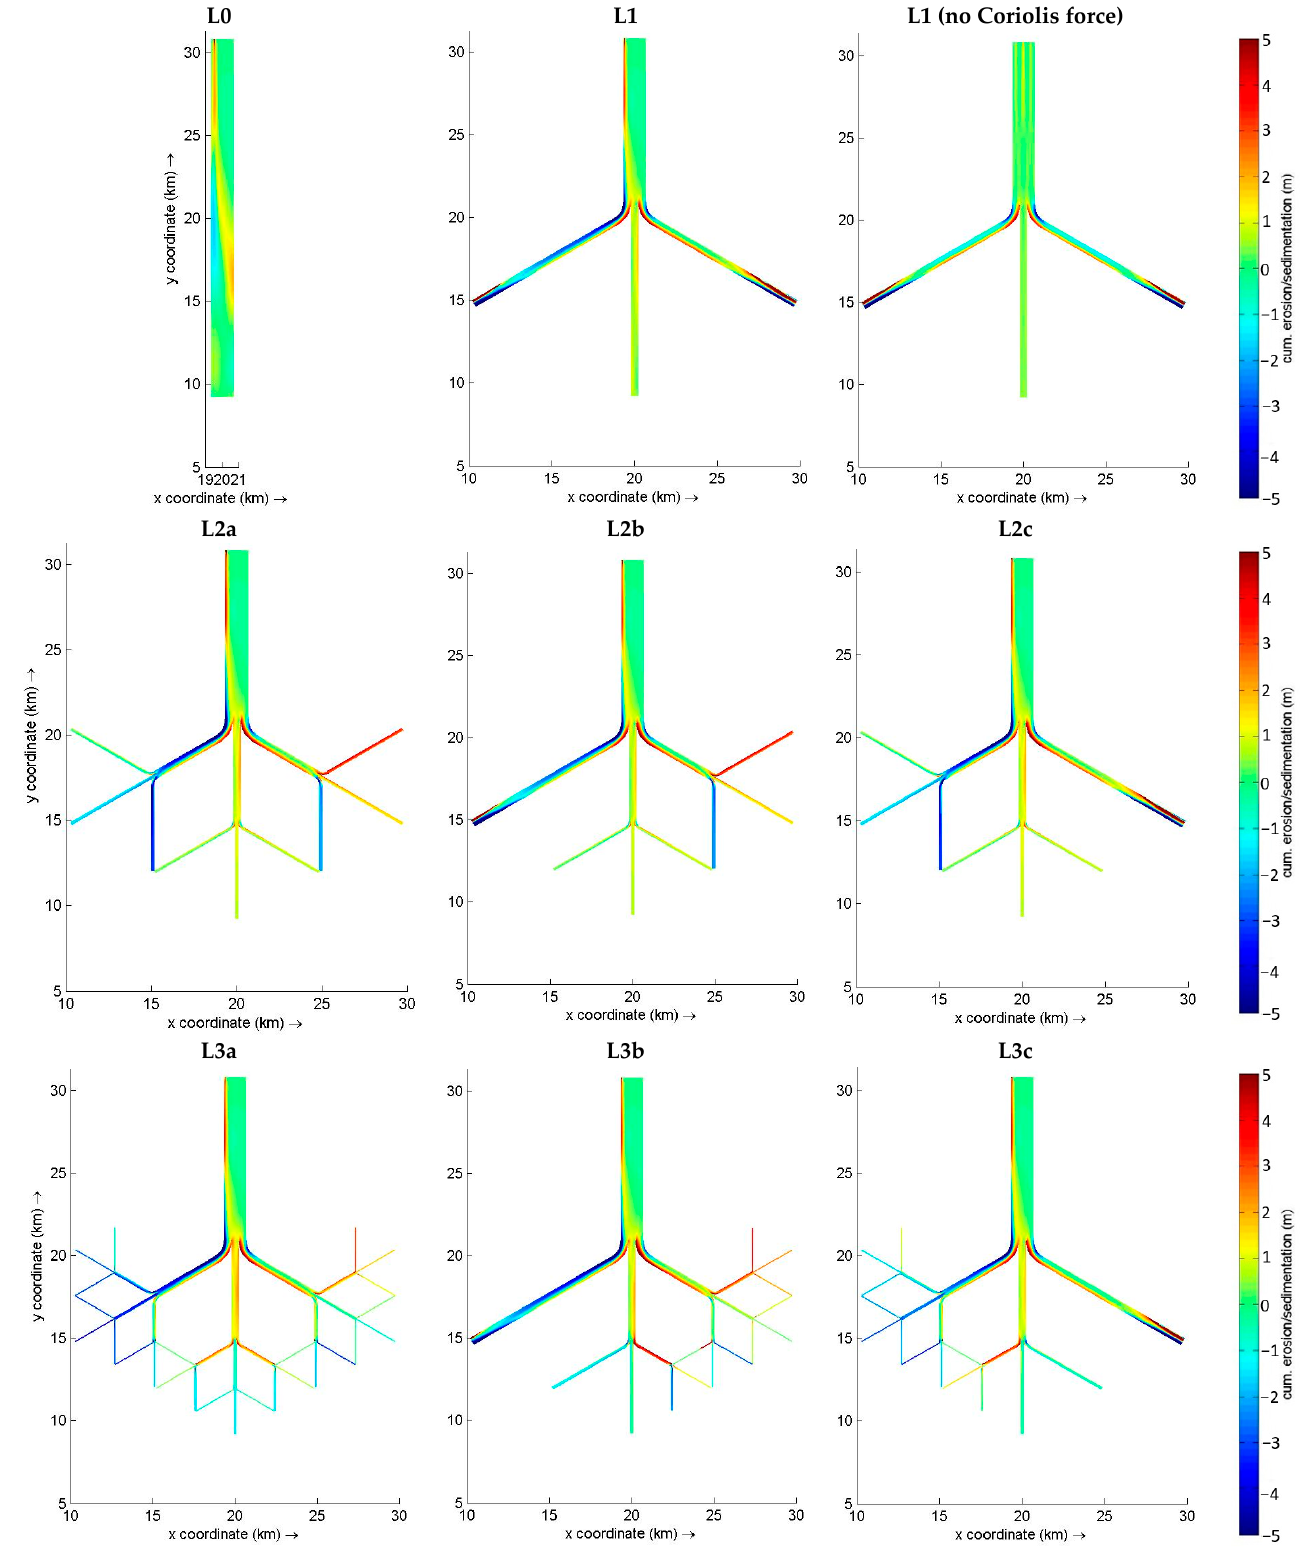
Figure 7. Bed level changes after 10 years for each deltaic system. To test the effects of symmetry, we designed asymmetrical systems for L2 and L3. The sedimentation/erosion patterns in the more complex sides of L2b and L2c were almost identical to those in the corresponding side of L2a, which means the symmetry had little